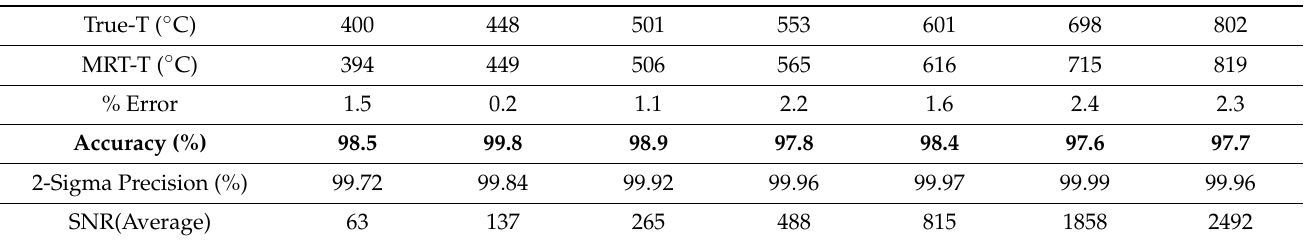
Table 5. Steady state MRT results (MRT-T) from the pyrometry instrument at seven